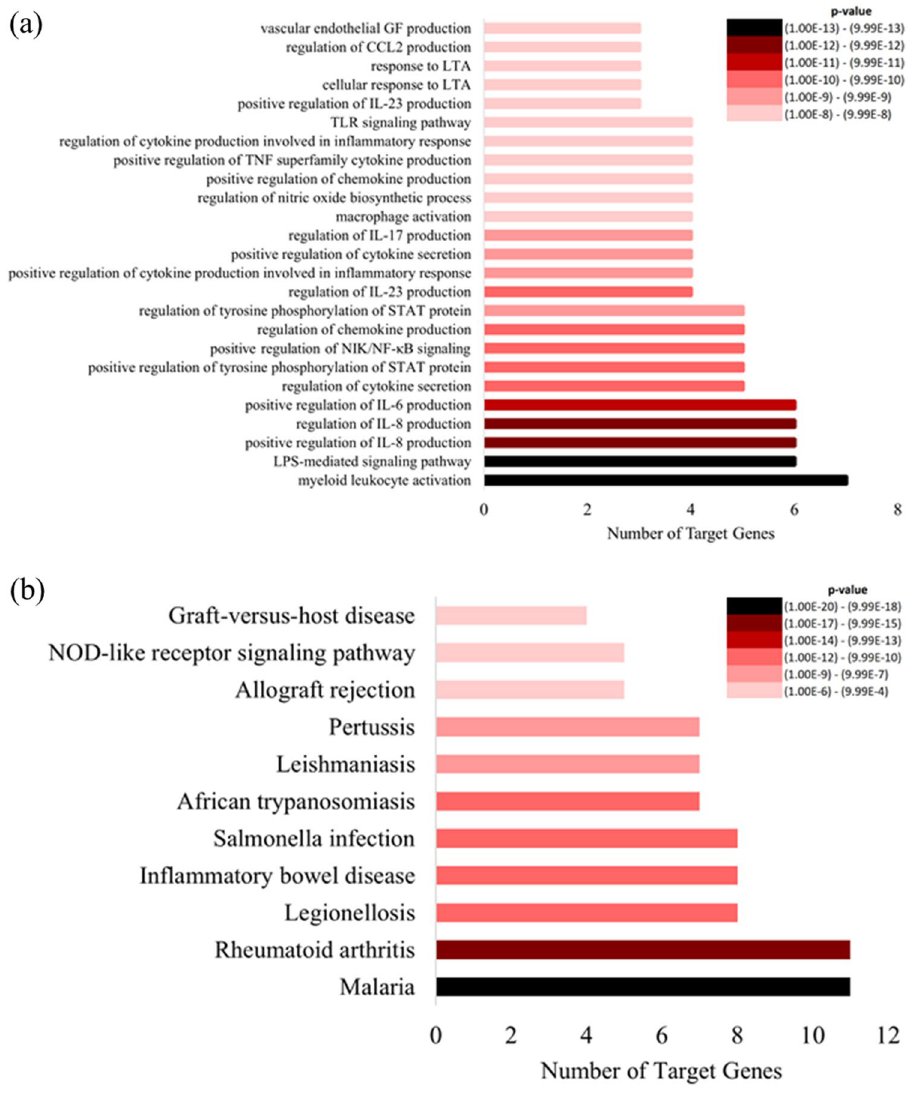
Figure 6. The biological processes and the number of target genes involved ( a ); and pathways and corresponding number of target genes ( b ). In both ( a ) and ( b ), black bars indicate biological processes/pathways predicted with the lowest p -value; lightest red bar represents predictions with the greatest p -value. Figure created with Microsoft Excel (2013) (https:// www. micro soft. com/ en- us/ micro soft- 365/